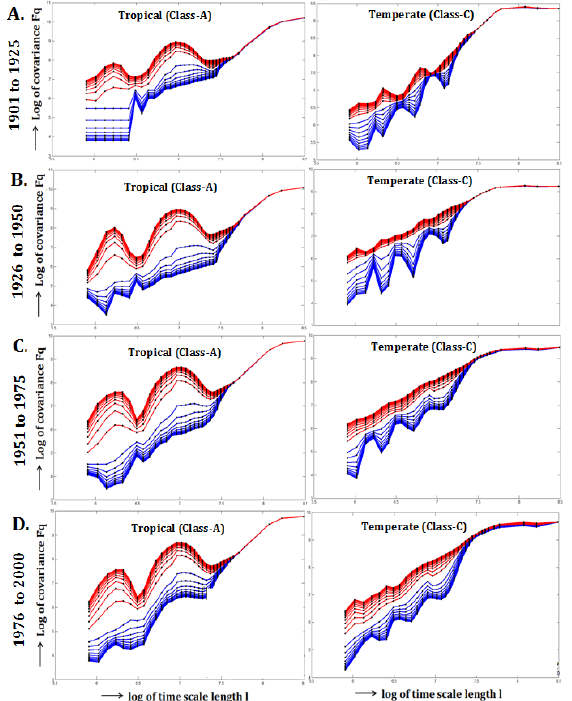
Figure 5. Multifractal cross-correlation pattern of different cli- mate